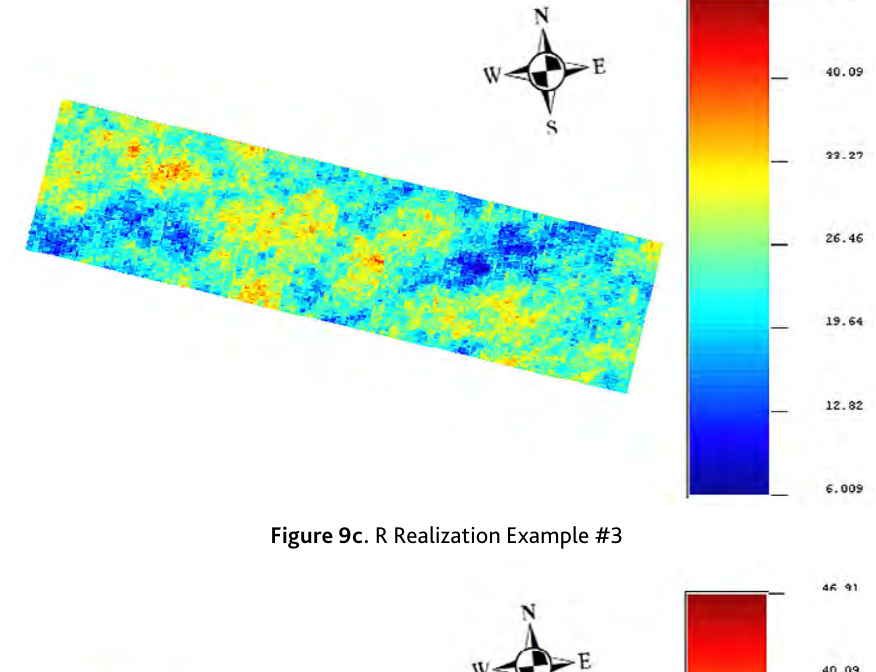
Figure 9c. R Realization Example #3